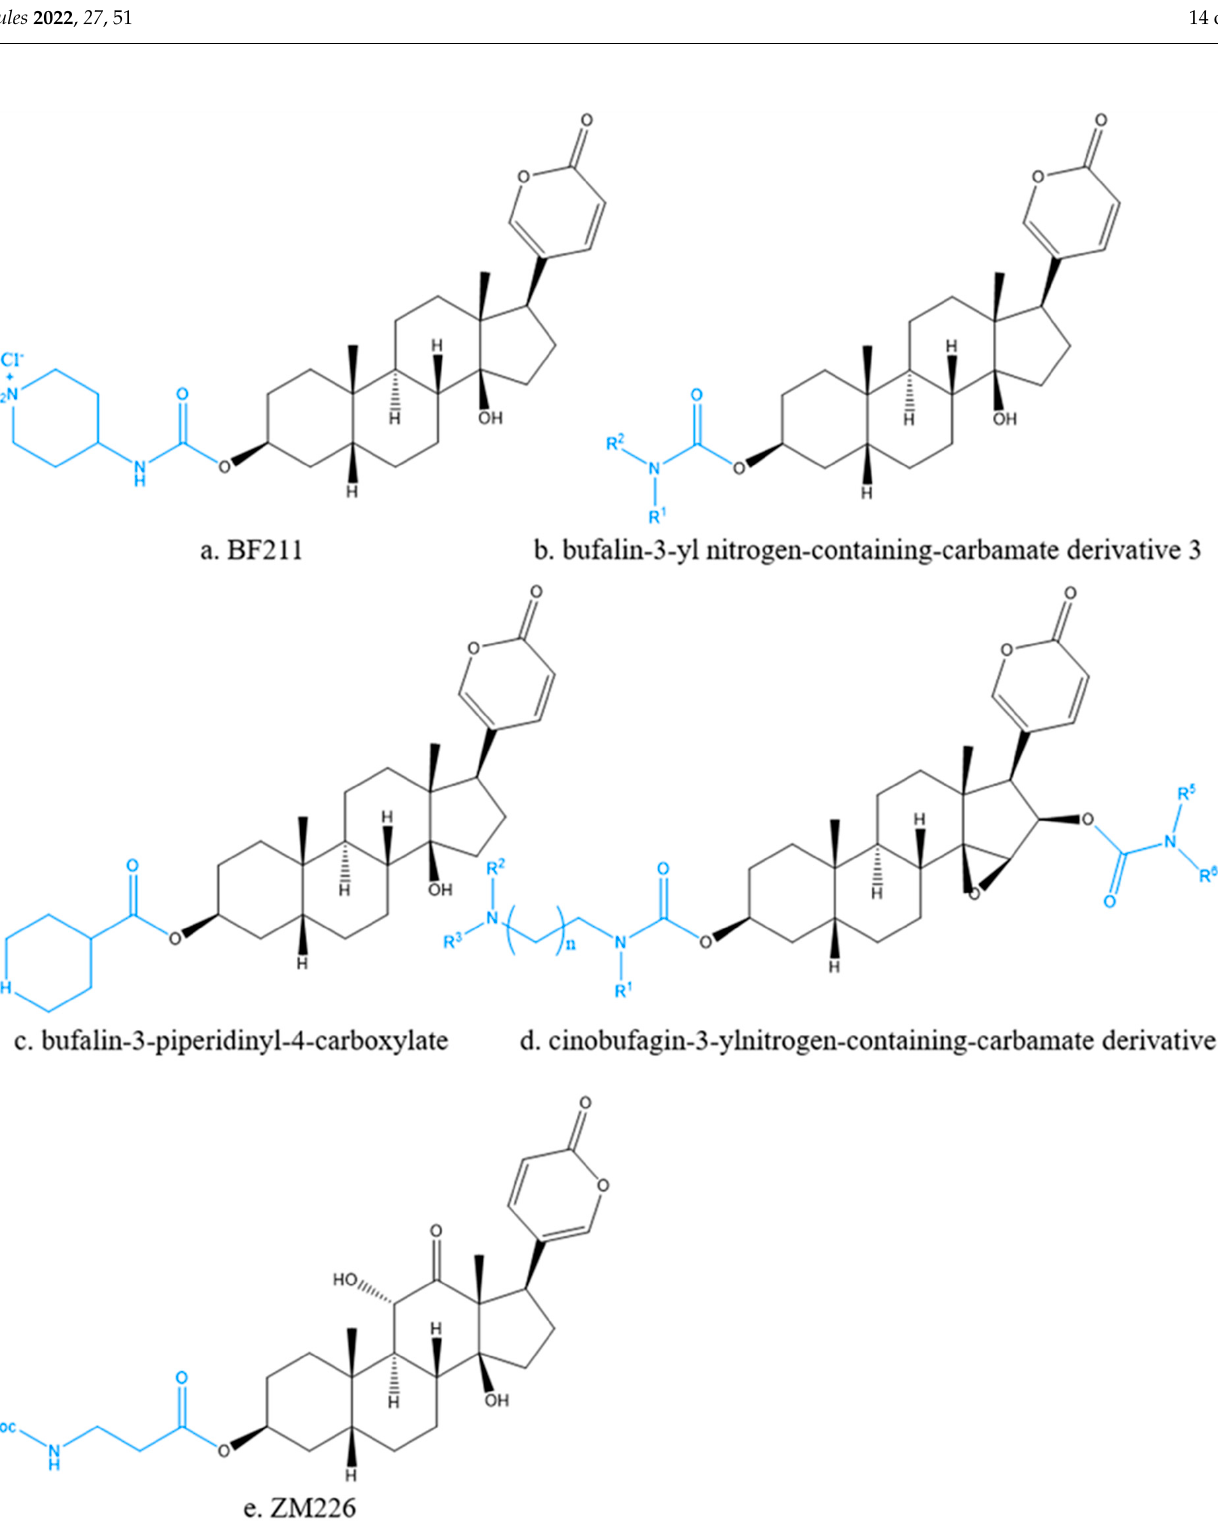
Figure 6. The derivatives of bufadienolides.